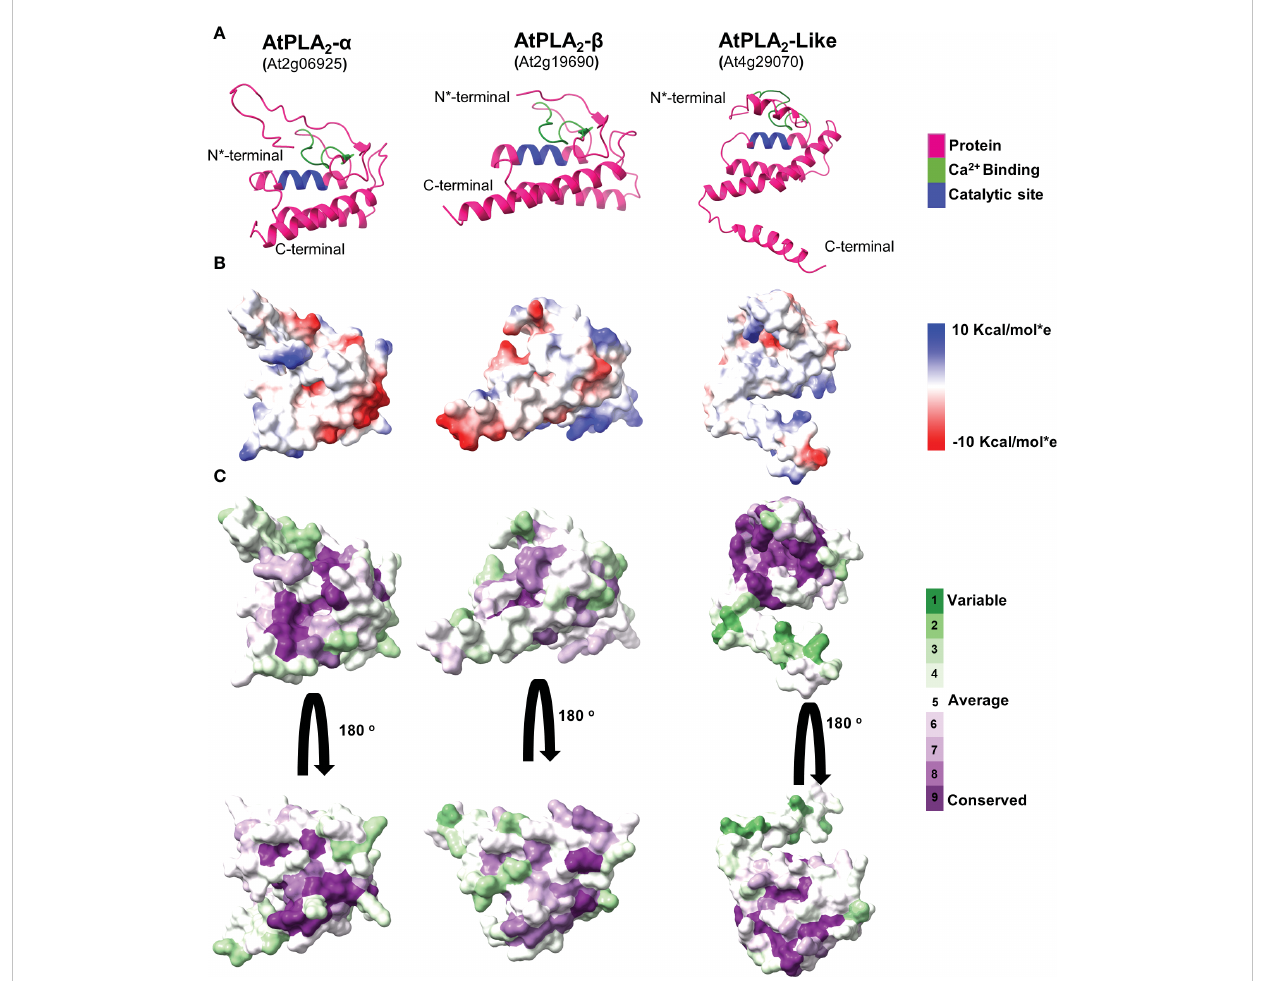
FIGURE 5 A comparative analysis of predicted Arabidopsis PLA 2 structural models. (A) Cartoon representation of sPLA 2 - a , PLA 2 - b , and PLA 2 -like protein models. (B) A comparative analysis of the Coulombic electrostatic potential distribution among PLA 2 members, calculated with the ChimeraX software. (C) Analysis of conserved residues on the sPLA 2 and PLA 2 surfaces, calculated using the Consurf